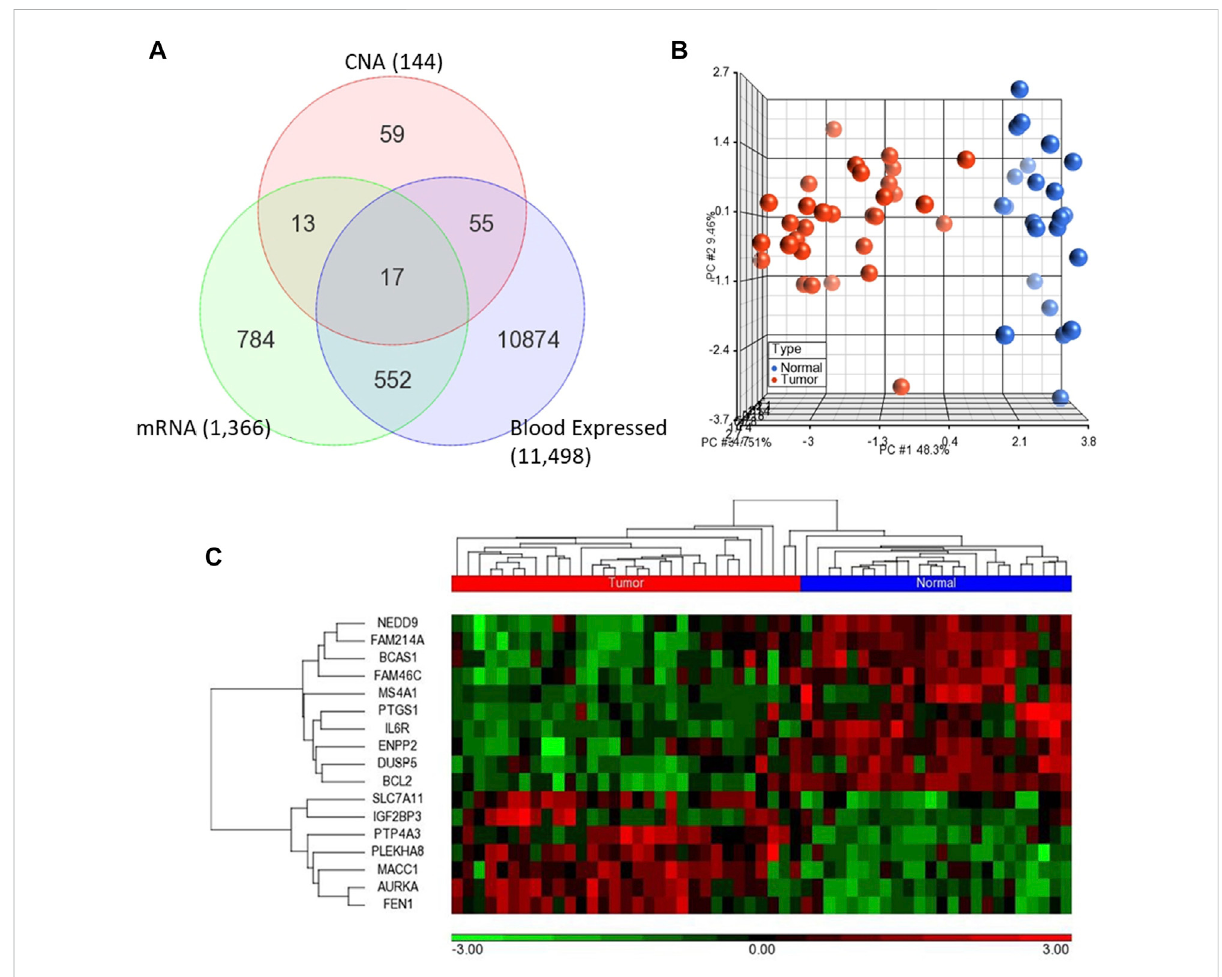
FIGURE 2 (A) Venndiagramrepresentingtheoverlapping17genesamongdifferentiallyexpressedgenes(mRNA)andCNAthatarealsoexpressedinblood (B – C) Unsupervisedprincipalcomponentanalysis(PCA)andtwo-dimensionalhierarchicalclusteringusing17-genesignatureontheGSE23878.The red spheres refer to tumors and blue ones for normal controls. The hierarchical clustering resulted in two main clusters of tumors and controls. Samples are denoted in columns and genes are denoted in